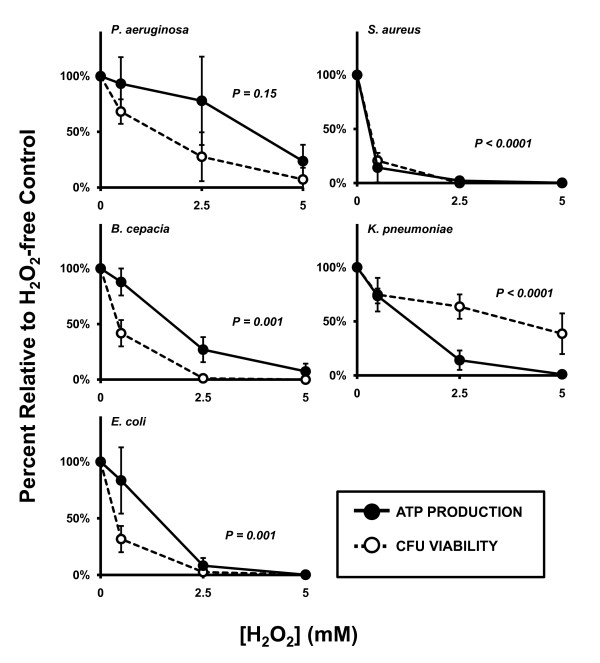
Correlating H2O2-induced loss of ATP production with bacterial viability. H2O2-induced disruption of ATP production correlated statistically with abolishment of CFU viability for all organisms tested except PsA (p = 0.15) at concentrations up to 5 mM. Though the decline of ATP production in PsA for this oxidant was statistically significant in this range, the percent change remains independent of the percent reduction in CFU viability. Solid circles and lines: ATP recovery after oxidant exposure. Open circles and dotted lines: CFU viability. Both parameters are measured as percent relative to oxidant-free controls. P-values represent linear regression of the raw data values from percent ATP recovery versus CFU viability. Values less than 0.05 were considered significant and denote correlation between the parameters; values greater than 0.05 indicate independence of the parameters. Error bars represent standard deviation of at least n = 3 experiments.